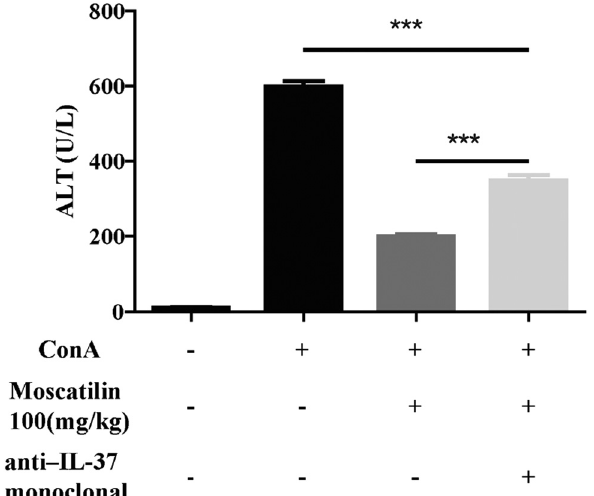
Figure A3: Blocking IL - 37 could reverse the e ff ects of moscatilin on the ConA induced liver damage. Serum level of alanine amino - transferase in the mice from di ff erent group at day 3 was detected by ELISA. Each group contained at least 10 mice and *** indicated p value less than 0.001 for comparation